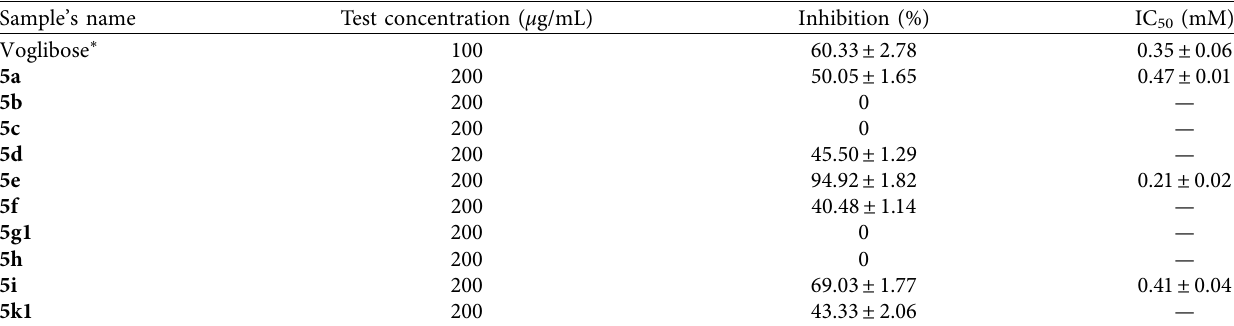
Table 2: α- Glucosidase inhibitory activity of the synthesized